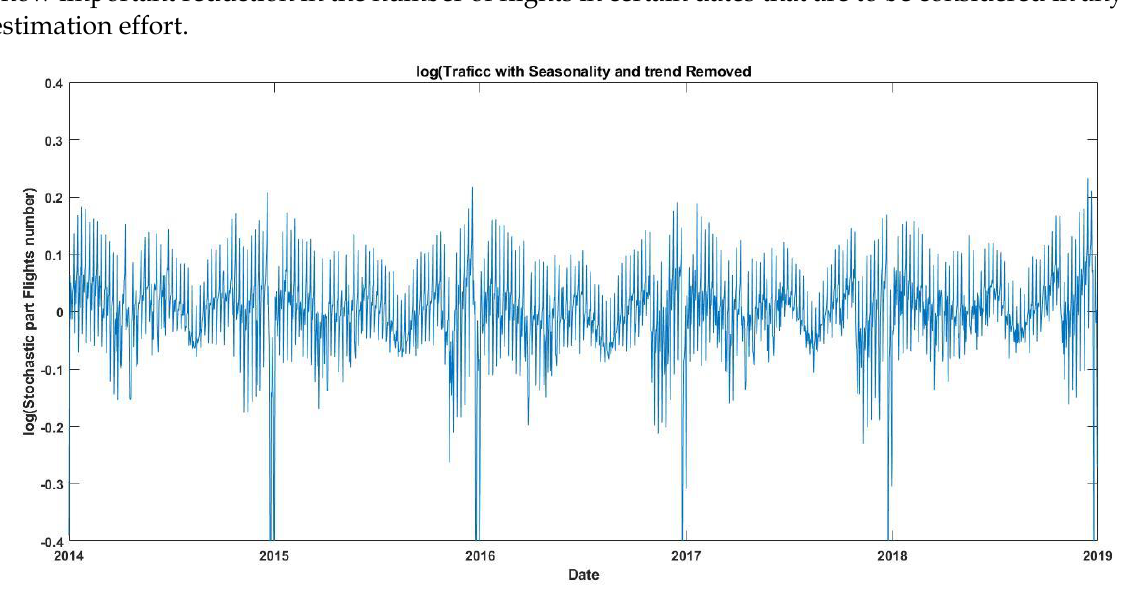
Figure 6. Stochastic part of flight traffic from 2014 to